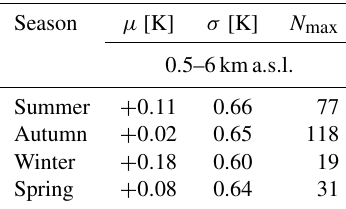
Table 7. Seasonal mean bias µ , standard deviation σ and maximum availability N max at